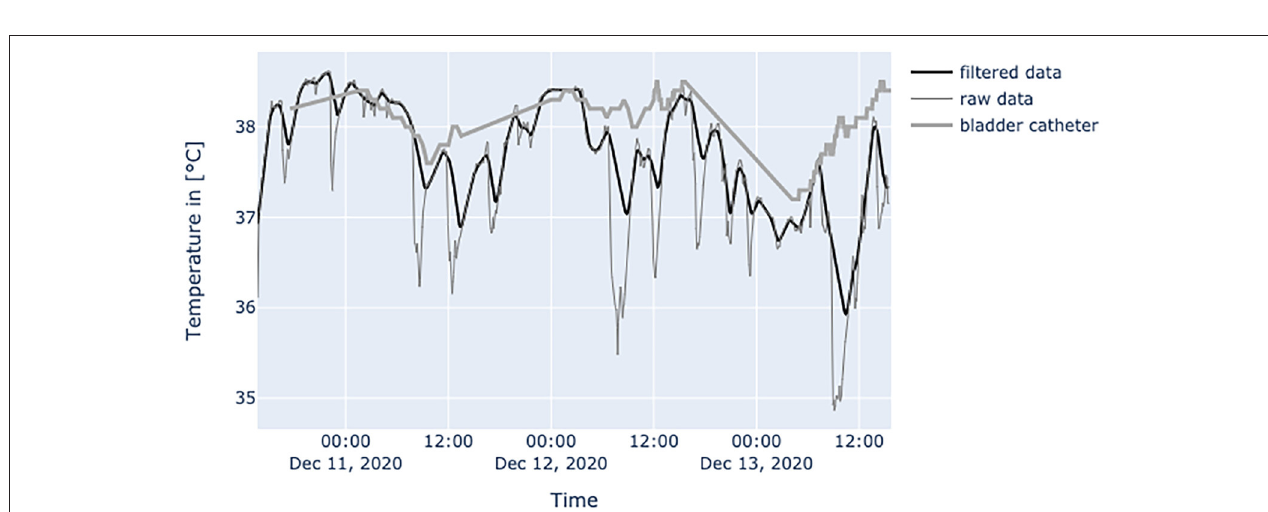
FIGURE 5 | Histogram shows the distribution of the temperature values in the non-febrile group.